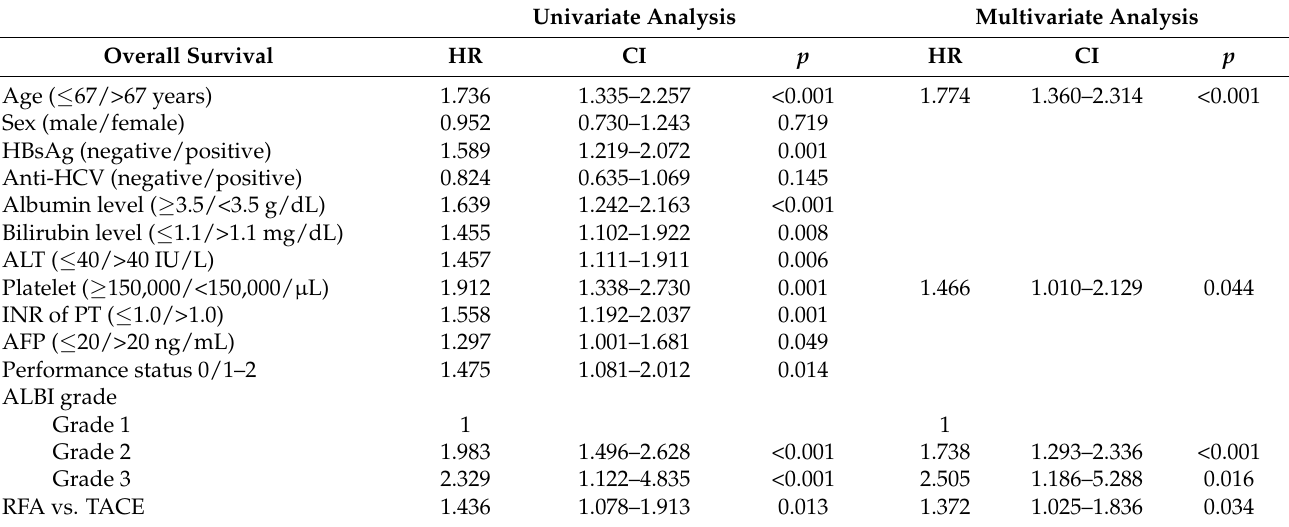
Table 3. Multivariate Cox analysis for RFA vs. TACE in HCC patients with low tumor burden score (n =